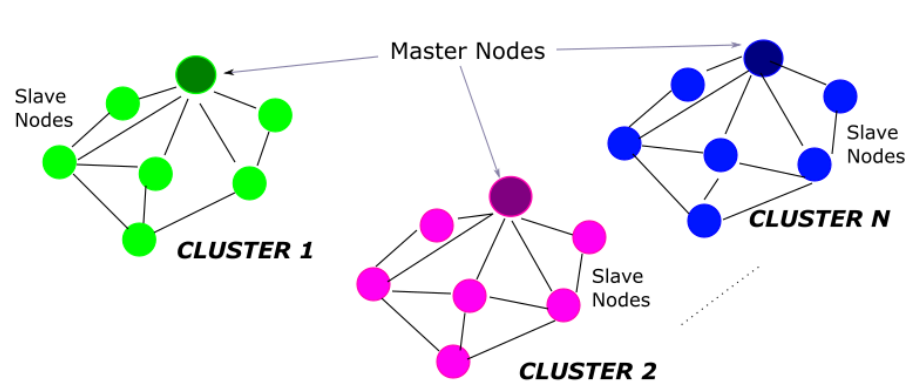
Figure 1. Wi-GIM network